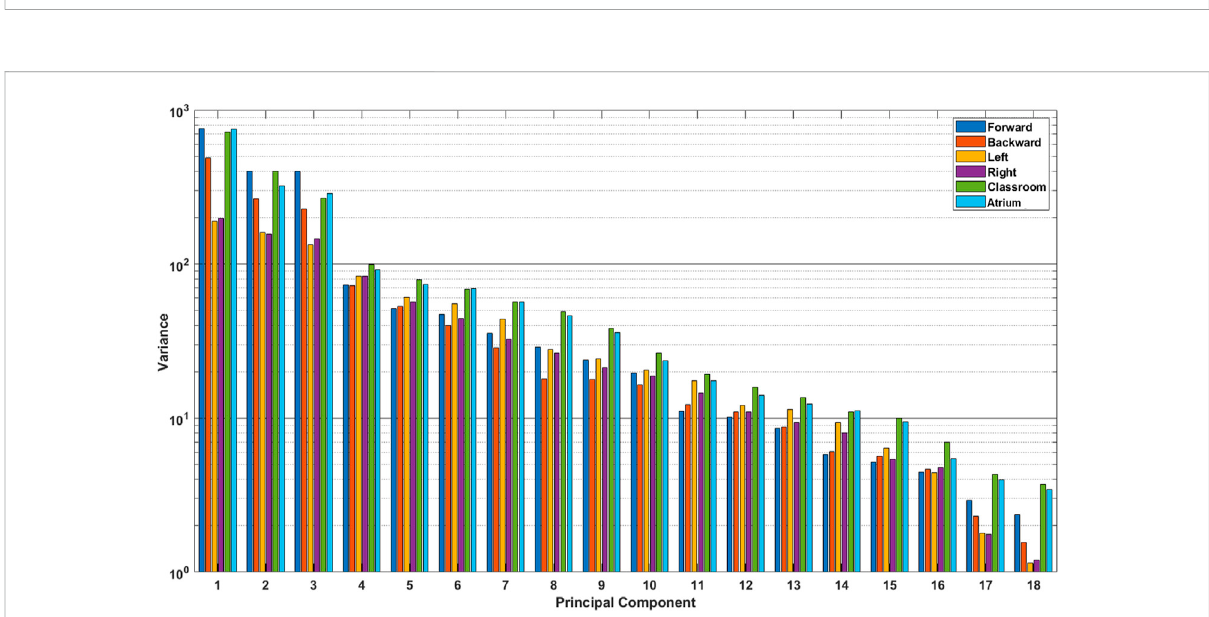
variance indicating tighter coordination of joints, while Classroom shows the largest value, indicating more variability in joint angles and less coordination amongst them. Figure 6B shows that backward walking has the largest GaitSD, indicating greater stride to stride variability of joint